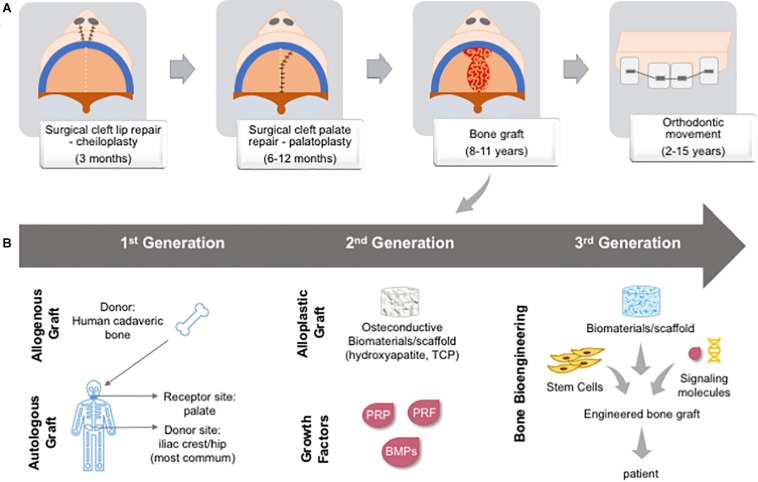
Cleft lip and/or palate patient chronological management over time and types of bone graft. (A) First, patients are submitted to a lip reconstruction (around 3 months); followed by palate reconstruction (between 6–12 months); primary bone graft in the hard palate (between 8–11 years); and, then orthodontic movement (between 2–15 years). (B) Bone graft was developing from gold-standard autologous and allogenous graft (1st generation), the development of osteoconductive biomaterials and recombinant growth factors or natural adjuvants (2nd generation), and bone bioengineering is bringing a new possibility to associate stem cells from patient, biomaterials and signaling molecules to create an in vitro engineered bone graft to be implanted in the patient, being a personalized approach (3rd generation). BMP: bone morphogenetic protein; PRF: platelet-rich fibrin; PRP: platelet-rich plasma; TCP: tricalcium phosphate.